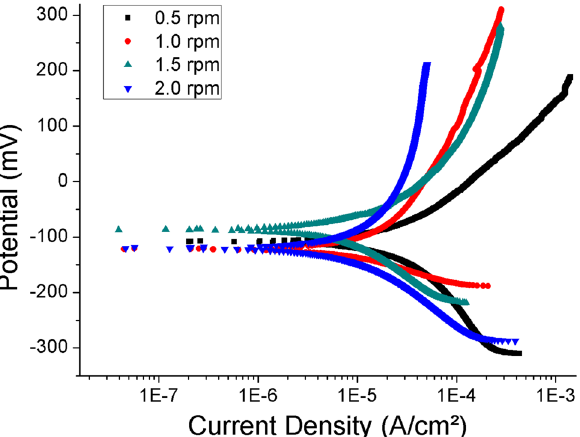
Figure 14. Potentiodynamic polarization curves obtained in 3.5 wt.% NaCl solution for CrN/Cr 1-x Al x N multilayers with distinct periodicities produced at the constant bias of − 150 V and by varying the rotational speed of the carousel.